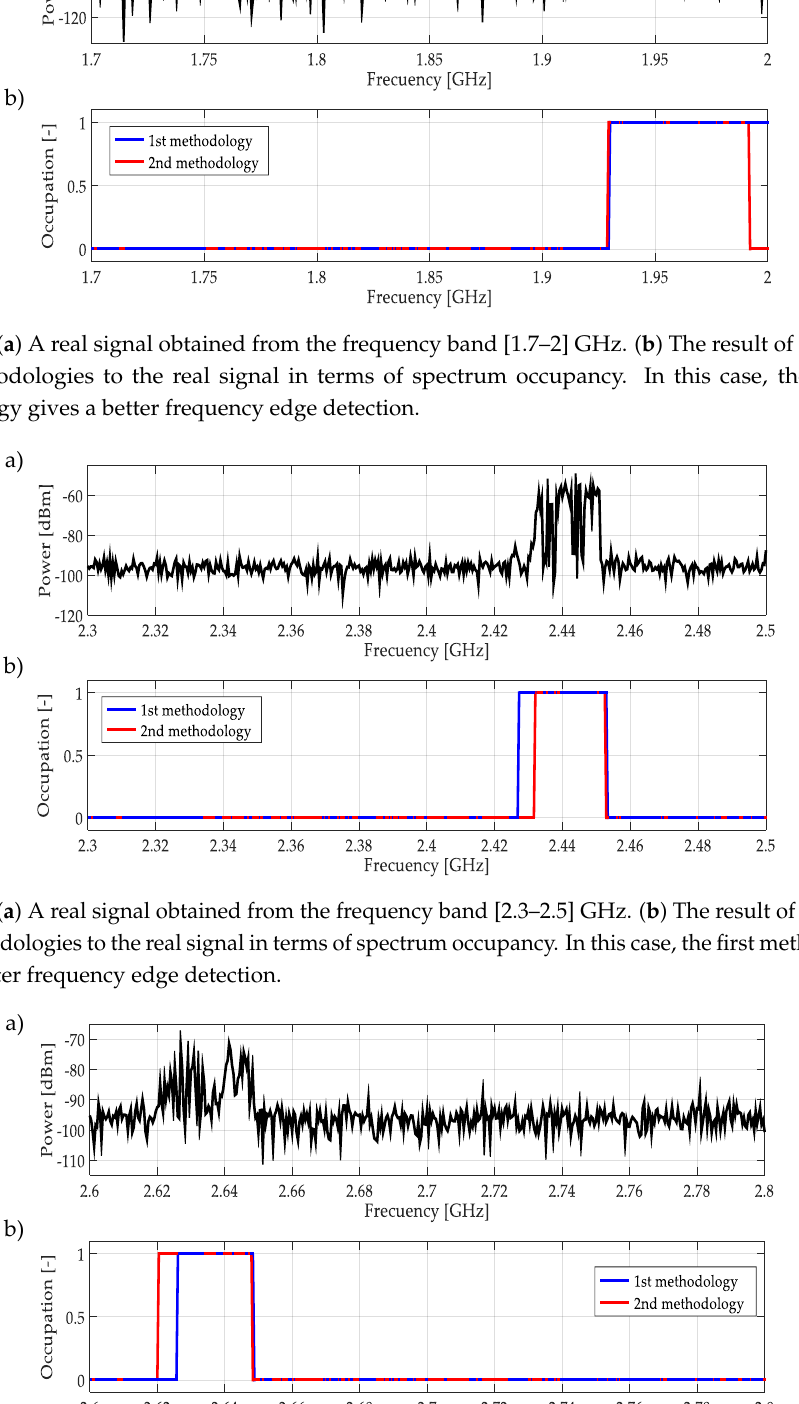
Figure 26. ( a ) A real signal obtained from the frequency band [2.6 – 2.8] GHz. ( b ) The result of applying